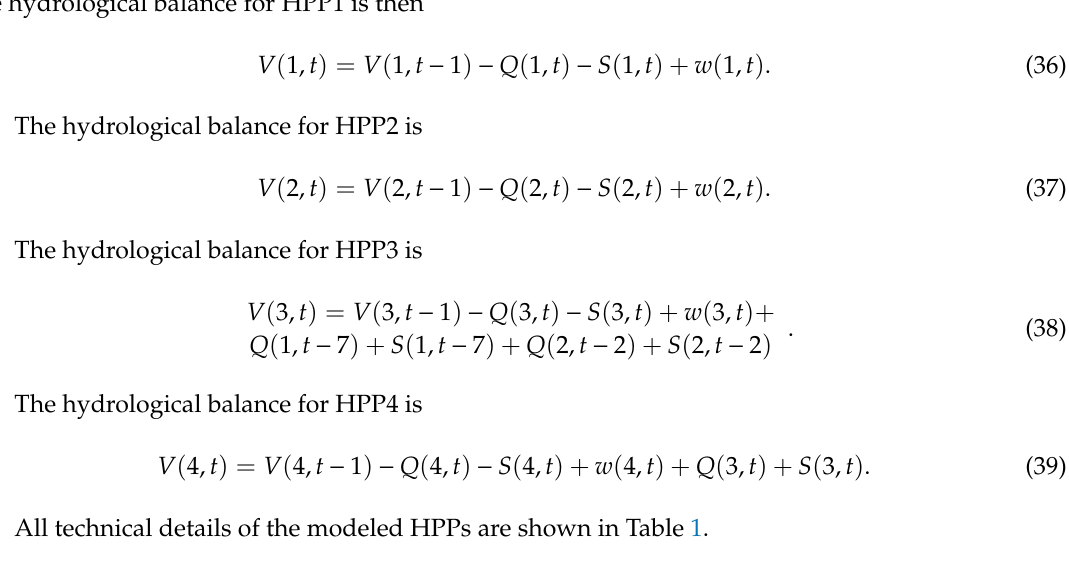
Table 1. Technical characteristics of the hydropower plants (HPPs). HE—hour